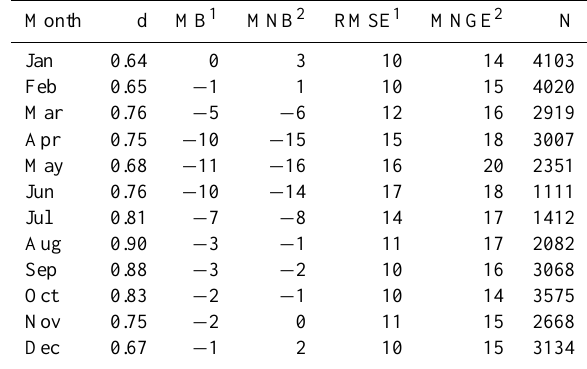
Fig. 7. Comparison of the vertical profiles of ozone mixing ratios retrieved by TES and simulated by WRF-Chem during winter, spring, summer and autumn 2008. WRF-Chem profiles are transformed using TES averaging kernel and a priori profile before this comparison. The vertical profiles are obtained using co-located WRF-Chem and TES data. Numbers on the right in each panel give the difference in ozone mixing ratios between WRF-Chem and TES (WRF-Chem – TES). Table 2. Seasonal variation in index of agreement (d), mean bias (MB), mean normalized bias (MNB), root-mean-square er- ror (RMSE) and mean normalized gross error (MNGE) computed using the co-located WRF-Chem and TES ozone values (year 2008) in the lower troposphere (Surface – 500hPa). The total number of data points (N) used in the calculation is also